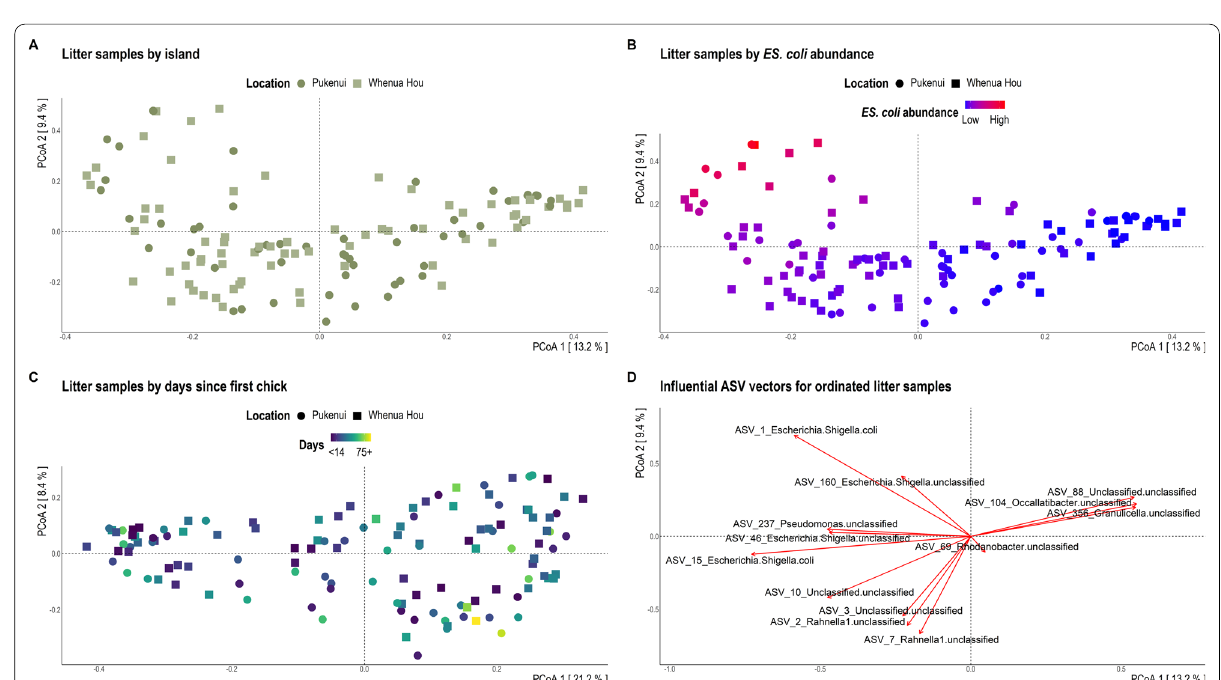
Fig. 2 Bray–Curtis dissimilarity distances of 16S rRNA gene sequences for litter samples visualised via principal coordinate analysis (PCoA) ordination. Each dot of the PCoA represents the microbiota of a single nest litter sample. Samples are shaped by island location and coloured by A island location, B relative abundance of Escherichia-Shigella coli, and C number of days since the nest sampled first housed a chick. Panel D depicts the most influential ASV vectors plotted using the vegan::envfit